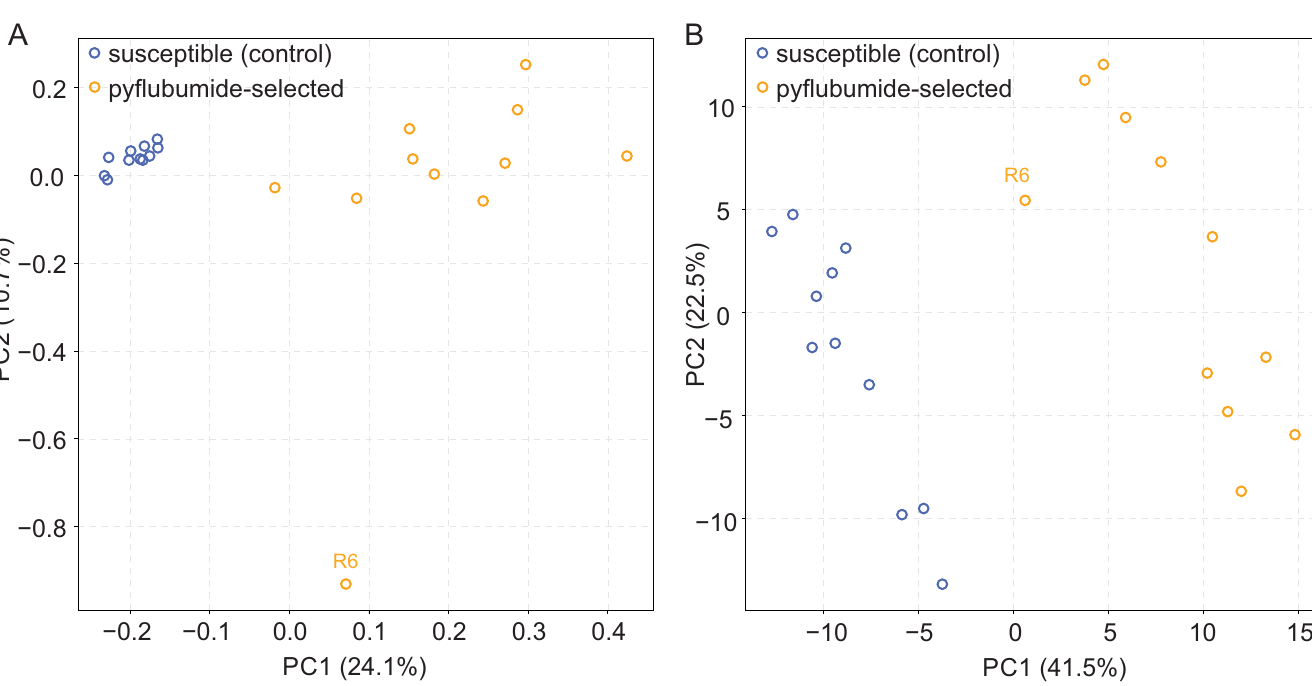
Fig 3. Selection for pyflubumide resistance is associated with a genomic and transcriptomic response. (A) A principal component analysis of the eleven susceptible (control) and pyflubumide-selected populations using genome-wide allele frequency data at informative genomic loci. (B) A principal component analysis of the eleven susceptible (control) and pyflubumide-selected populations using genome-wide transcript levels. For both panels, each circle represents an individual population, the R6 population is labelled, treatment is color-coded as indicated (top left), and the percentage of explained variance is given in parentheses for each principal component (PC).